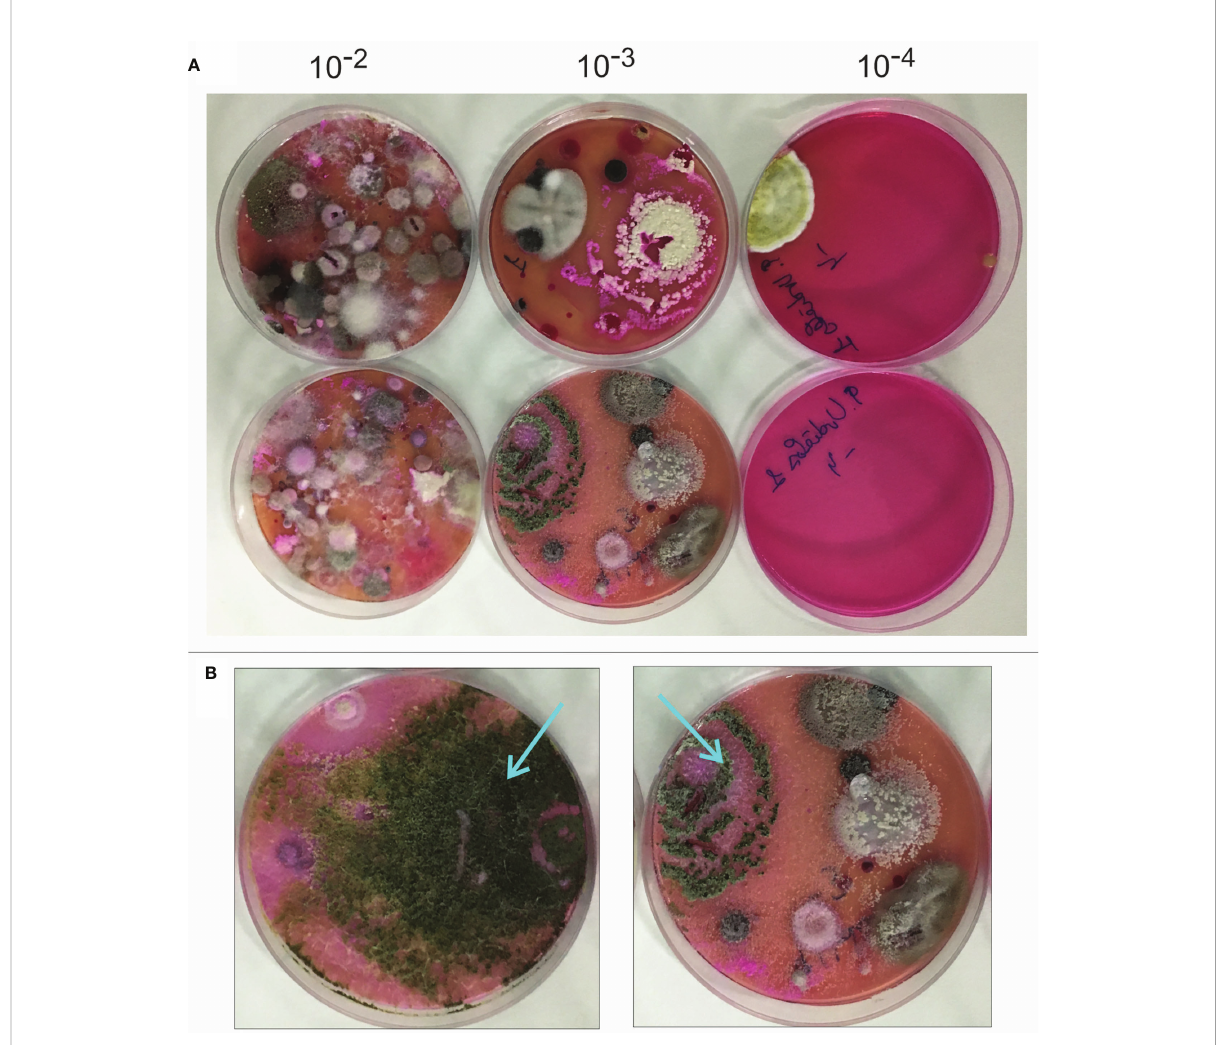
FIGURE 1 Isolation of Trichoderma strains from bean crop soils. (A) aspect of colonies isolated in Rose Bengal-Chloramphenicol medium used for fungal growth from dilutions 10 -2 to 10 -4 of the different bean crop soils analyzed in this work. (B) Two Trichoderma colonies are pointed to show the characteristic shape of most of the colonies from the species belonging to the genus Trichoderma that have been isolated in the current